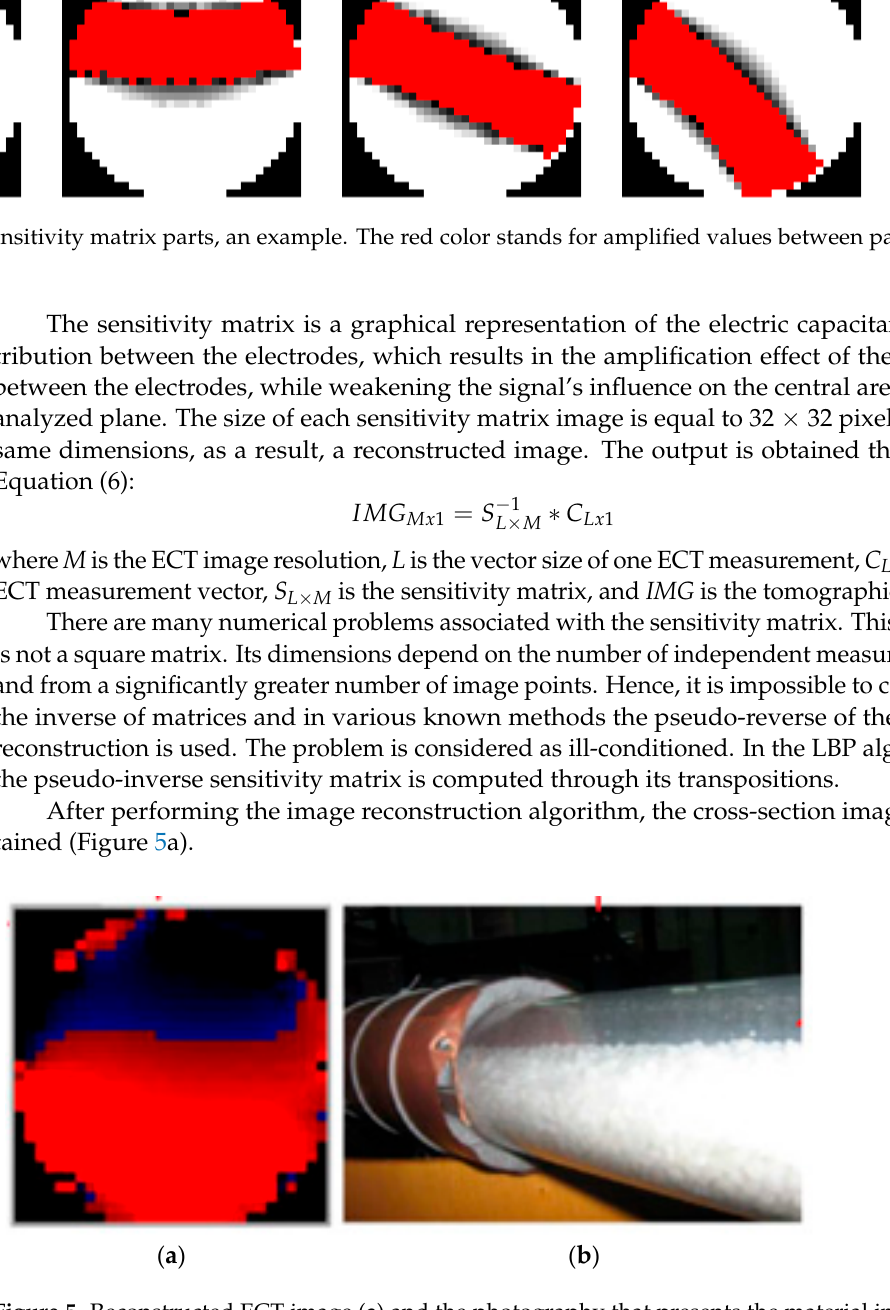
Figure 5. Reconstructed ECT image ( a ) and the photography that presents the material inside the pipe. ( b ) The red color shows the material inside the pipe, and the black color represents an empty part of the pipe. On the right hand, ( b ) the image of the pipe section is presented.